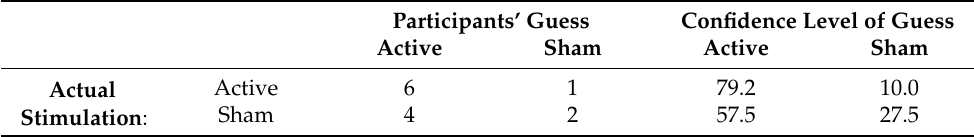
Table 1. Count of participants’ guess and averaged confidence level in their guess (from 0%: not confident to 100%: definitely confident in their guess) as a function of the true delivered stimulation.